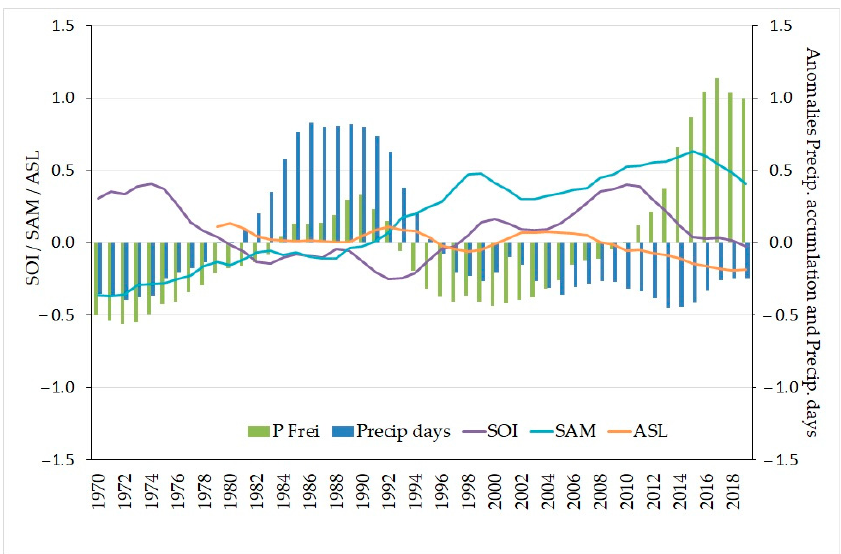
Figure 12. Annual SOI, SAM, and ASL indices along with the annual anomalies of the precipitation accumulation and precipitation days at Frei station. All data have been smoothed applying Equation (1).